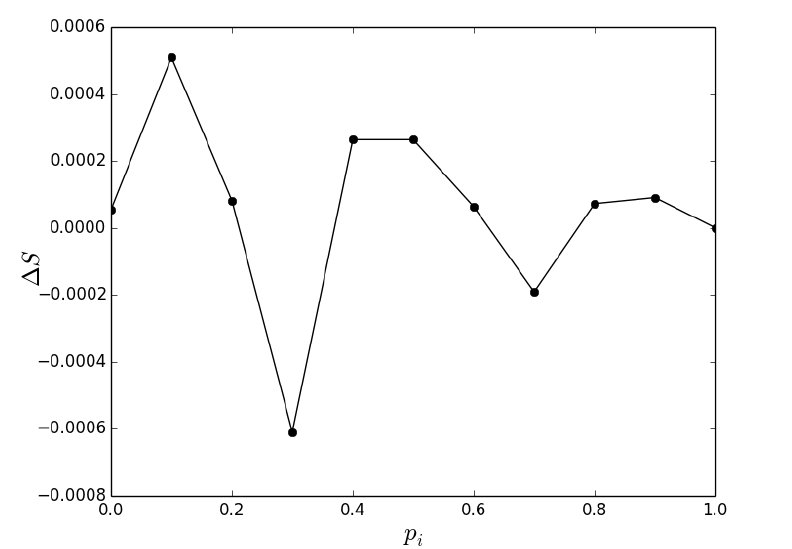
Figure 3. Average difference, in the summation of states ( + 1 indicates rational, − 1 irrational), obtained on varying the imitation probability, between results achieved in a well mixed population and in a structured population (i.e., regular square lattice with periodic boundary conditions). Results have been averaged over 100 simulation runs.